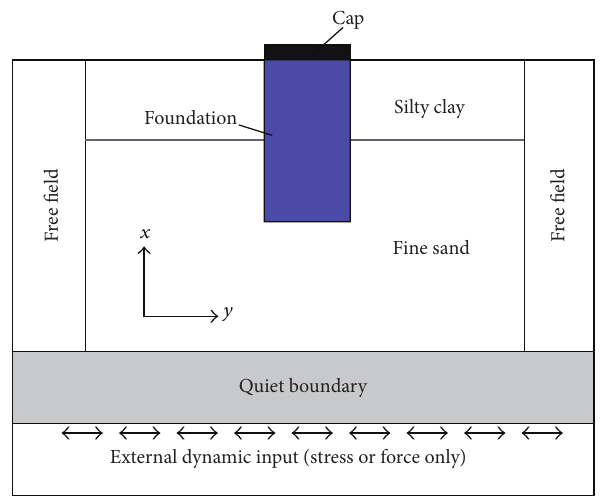
Figure 12: Dynamic boundary condition.